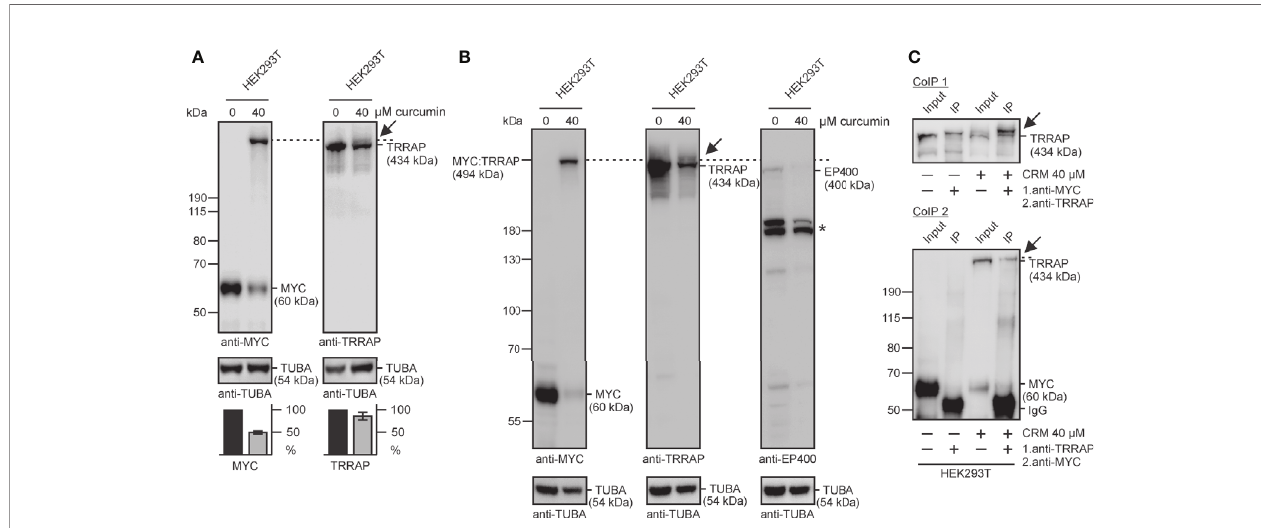
FIGURE 3 | Identi fi cation of the TRRAP coactivator interacting with MYC. (A) HEK293T cells were grown for 24 h in the presence of curcumin, and cell extracts prepared and analyzed by immunoblotting. Left panel: besides endogenous MYC with an apparent M r = 60,000, a protein band with an apparent M r of ~500,000 is detectable under curcumin using a MYC-speci fi c antibody (anti-MYC). Right panel: in the presence of curcumin, the TRRAP-speci fi c antibody (anti-TRAPP) recognizes an additional TRRAP-speci fi c protein migrating above the expected 434-kDa TRRAP protein (arrow). As a loading control, a -tubulin (TUBA) expression was analyzed. Lower panels: relative protein levels of MYC and TRRAP, quanti fi ed using the program ImageQuant. (B) HEK293T cells were treated with curcumin, and analyzed as under (A) using antibodies directed against MYC, TRRAP, EP400, and a -tubulin. The dashed lines in (A, B) depict the gel migration position of the MYC : TRRAP adduct migrating above the faint EP400-speci fi c band in the presence of curcumin. The star (*) indicates the position of EP400 degradation products. (C) Co-immunoprecipitation analysis using extracts from HEK293T cells treated with or without curcumin and MYC-speci fi c (CoIP 1), or TRRAP-speci fi c (CoIP 2) antibodies (anti-MYC, anti-TRRAP) for the fi rst precipitation under native conditions, and anti-TRRAP (CoIP 1), or anti-MYC (CoIP 2) for the immunological detection after protein blotting, respectively (CoIP 1: due to uneven gel electrophoresis the two input bands migrated slightly faster than the corresponding IP bands). Precipitated proteins were dissociated, and analyzed by SDS-PAGE and immunoblotting using anti-TRRAP or anti-MYC, respectively. As a reference 1% of the lysates were used as input controls. Representative experiments (n = 2) are